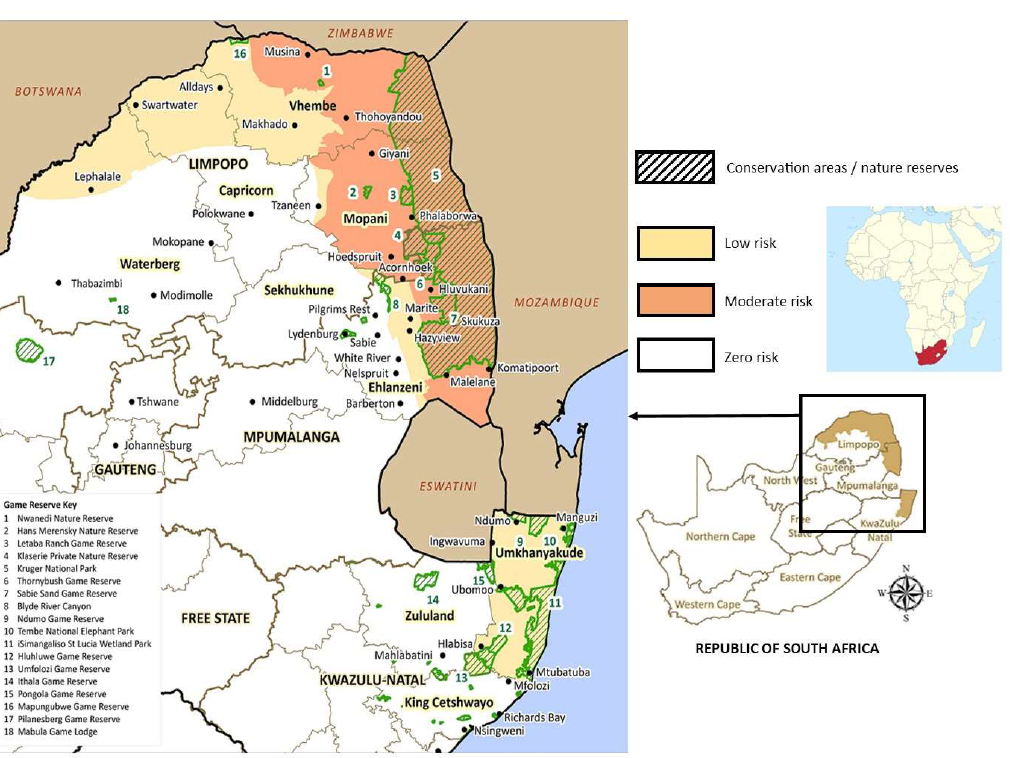
Figure 1. Malaria risk map for South Africa by endemic province and district/municipality. Adapted